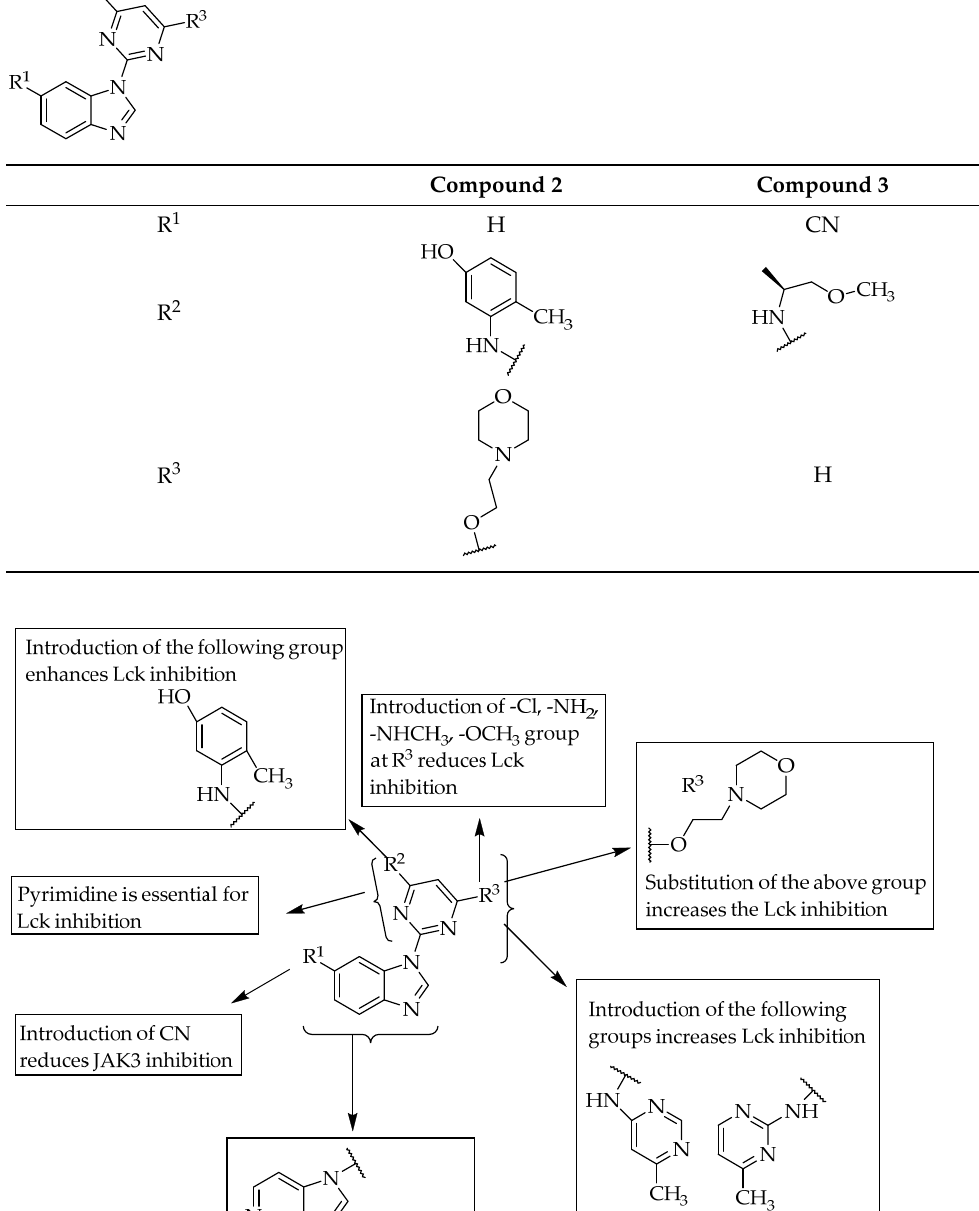
Table 1. N1-substituted benzimidazoles with pyrimidin-2-yl.